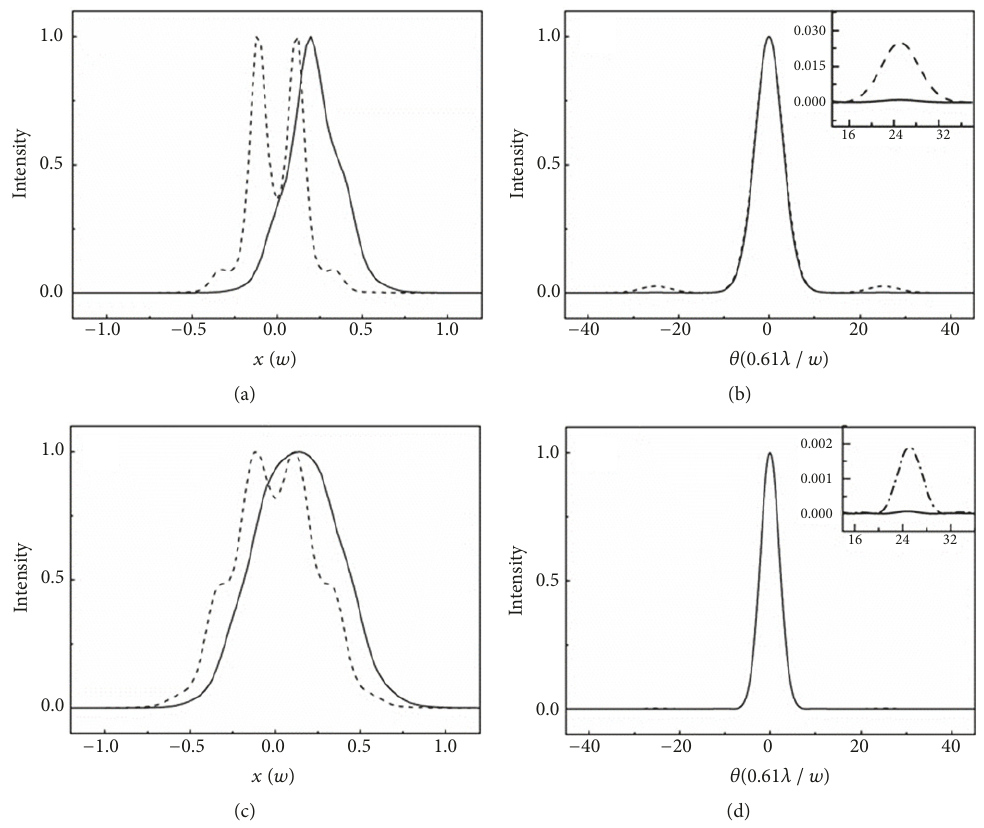
Figure 4: Near-field distribution (a, c) and angular spectrum (b, d) of the output signal when pump amplitude is modulated. Solid line: walk-off effect considered. Dashed line: no walk-off effect. (a) and (c) are stimulated under small-signal conditions ( E 0 = 10 −6 , L = 10 mm). (b) and (d) are calculated under saturation amplification conditions ( E 0 = 10 −2 , L = 5 mm). Other parameters are the same as those in Figure